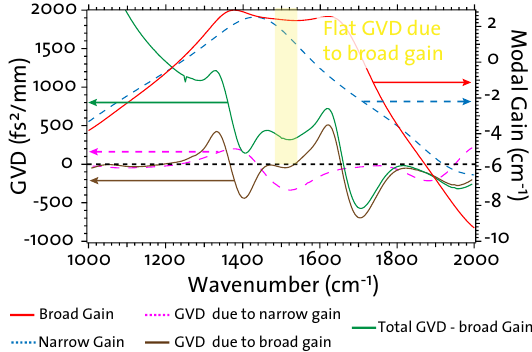
Figure 6: Computation of the GVD for the active region and effect of the gain bandwidth. Blue dashed line: a narrowband single stack active region. Solid red line: active region consisting of three stack. Laser structure from